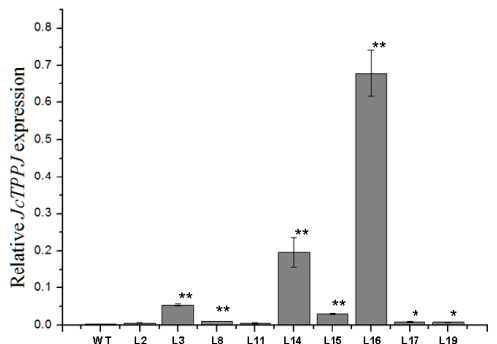
Figure 8. Relative expression levels of JcTPPJ in 35S:JcTPPJ transgenic Jatropha . The qRT ‐ PCR results were obtained from three independent biological replicates per sample from wild ‐ type (WT) and 35S:JcTPPJ transgenic Jatropha lines (L2, L3, L8, L11, L14, L15, L16, L17, and L19). The levels of detected amplification were normalized using the amplified products of the JcGAPDH gene as a reference. * indicates a significant difference at the p < 0.05 level, ** indicates a significant difference at the p < 0.01 level determined by one ‐ way ANOVA. The error bars represent the standard errors ( n = 3).